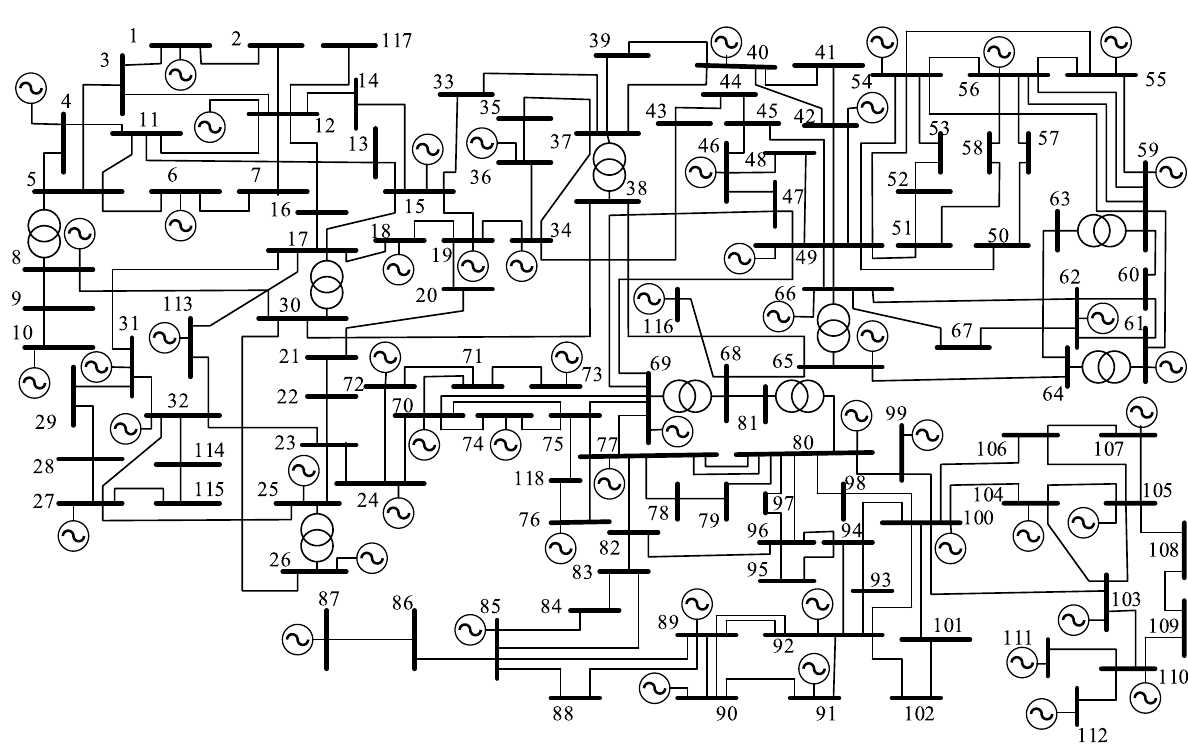
Fig. 5 Line diagram of the IEEE 118-bus test